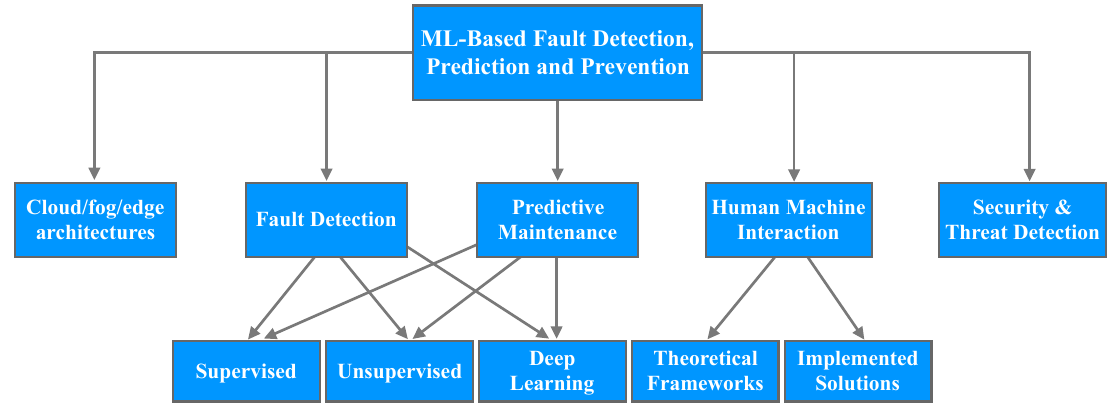
Figure 3. Structure of this